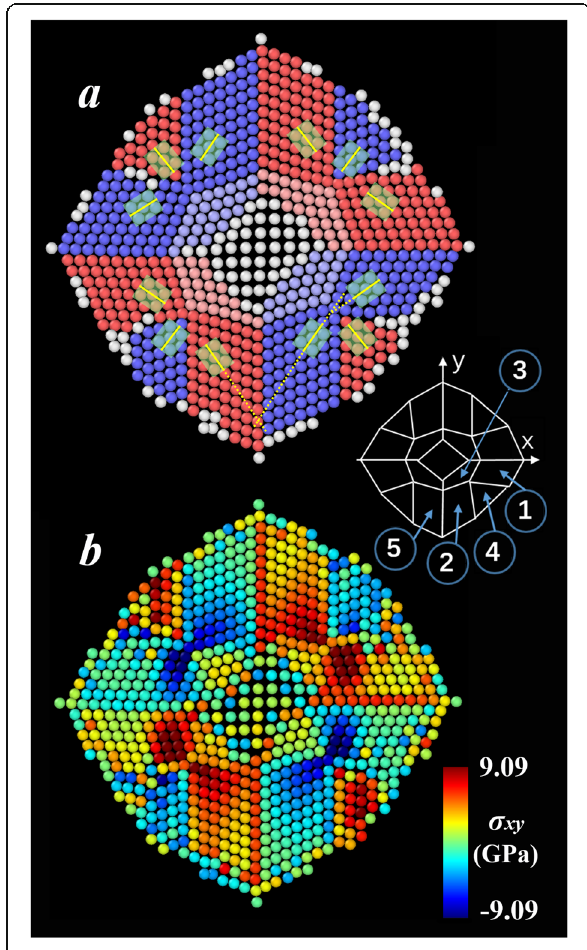
Fig. 2 a Snapshot of the upper surface of (001) nanoplate after relaxation at 1 K and b the corresponding shear stress